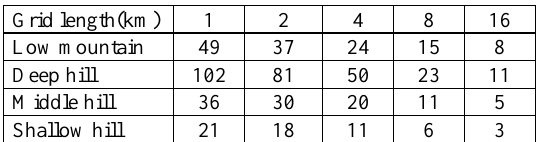
Table 2. Statistical results of space distribution box